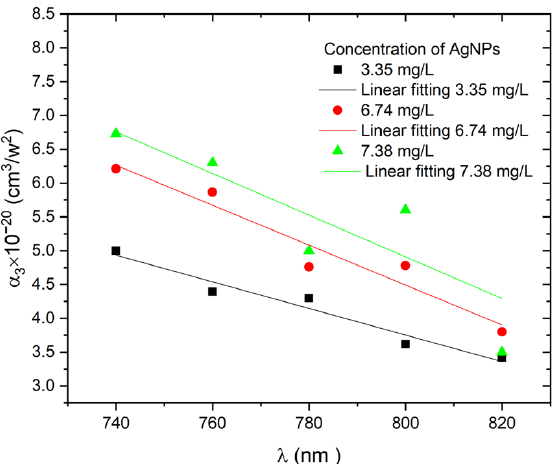
Figure 9. Dependence of α 3 on excitation wavelengths at constant AgNP concentrations and at constant excitation power of 1 W.